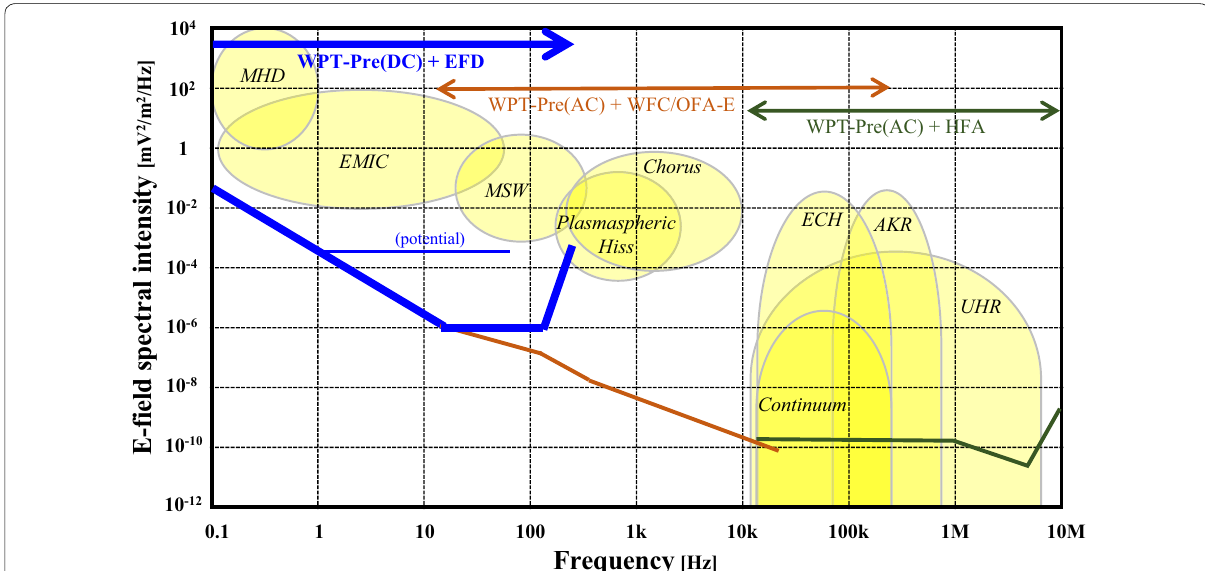
Fig. 7 Expected noise floor in the electric field (mV 2 /m 2 /Hz) due to WPT and EFD, WFC/OFA, and HFA. [Modified from Fig. 4 of Kasahara et al. (2017)]